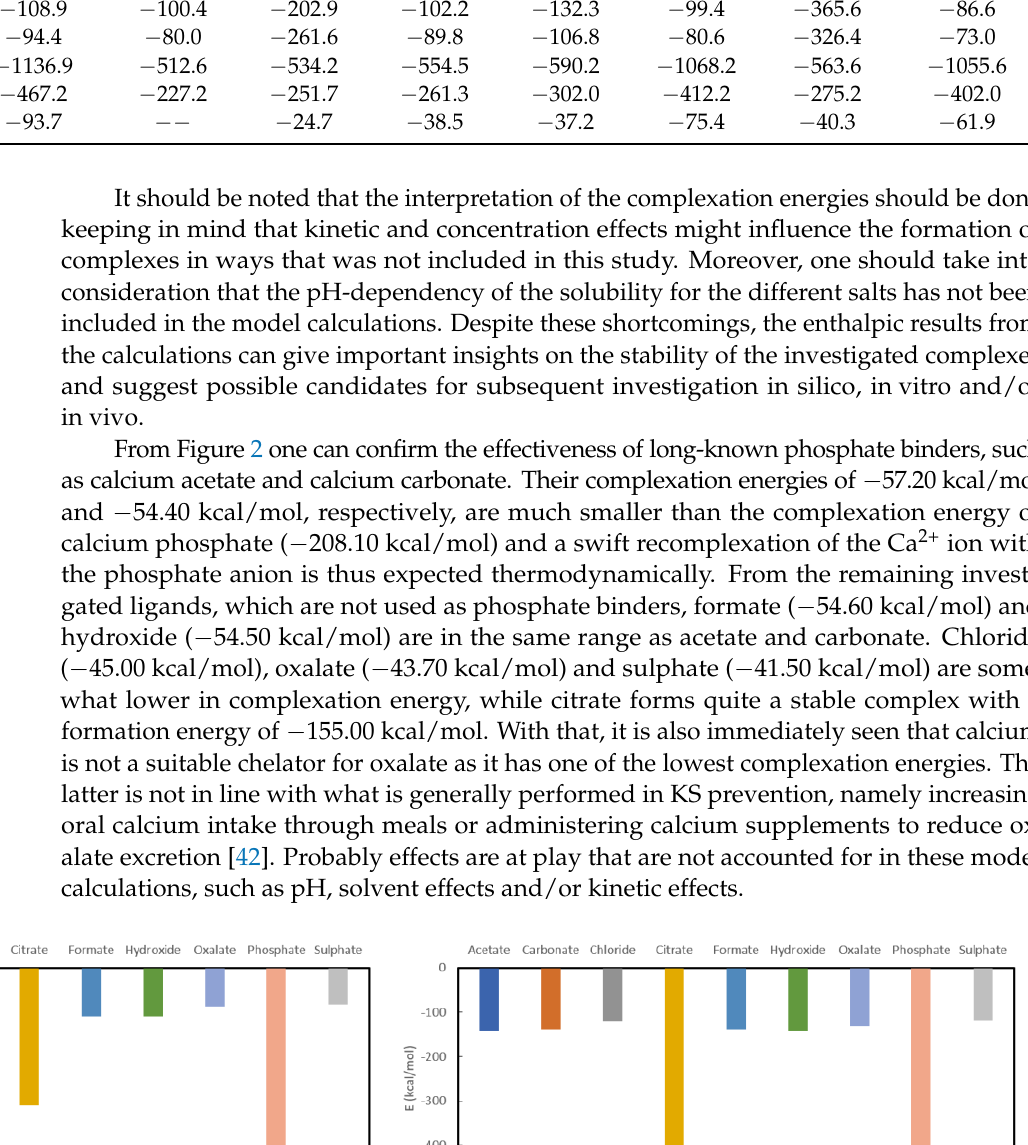
Table 1. Formation energies for all complexes considered in the present study in kcal/mol. For lanthanum chloride, no stable complex was found. Acetate Carbonate Chloride Citrate Formate Hydroxide Oxalate Phosphate Sulphate